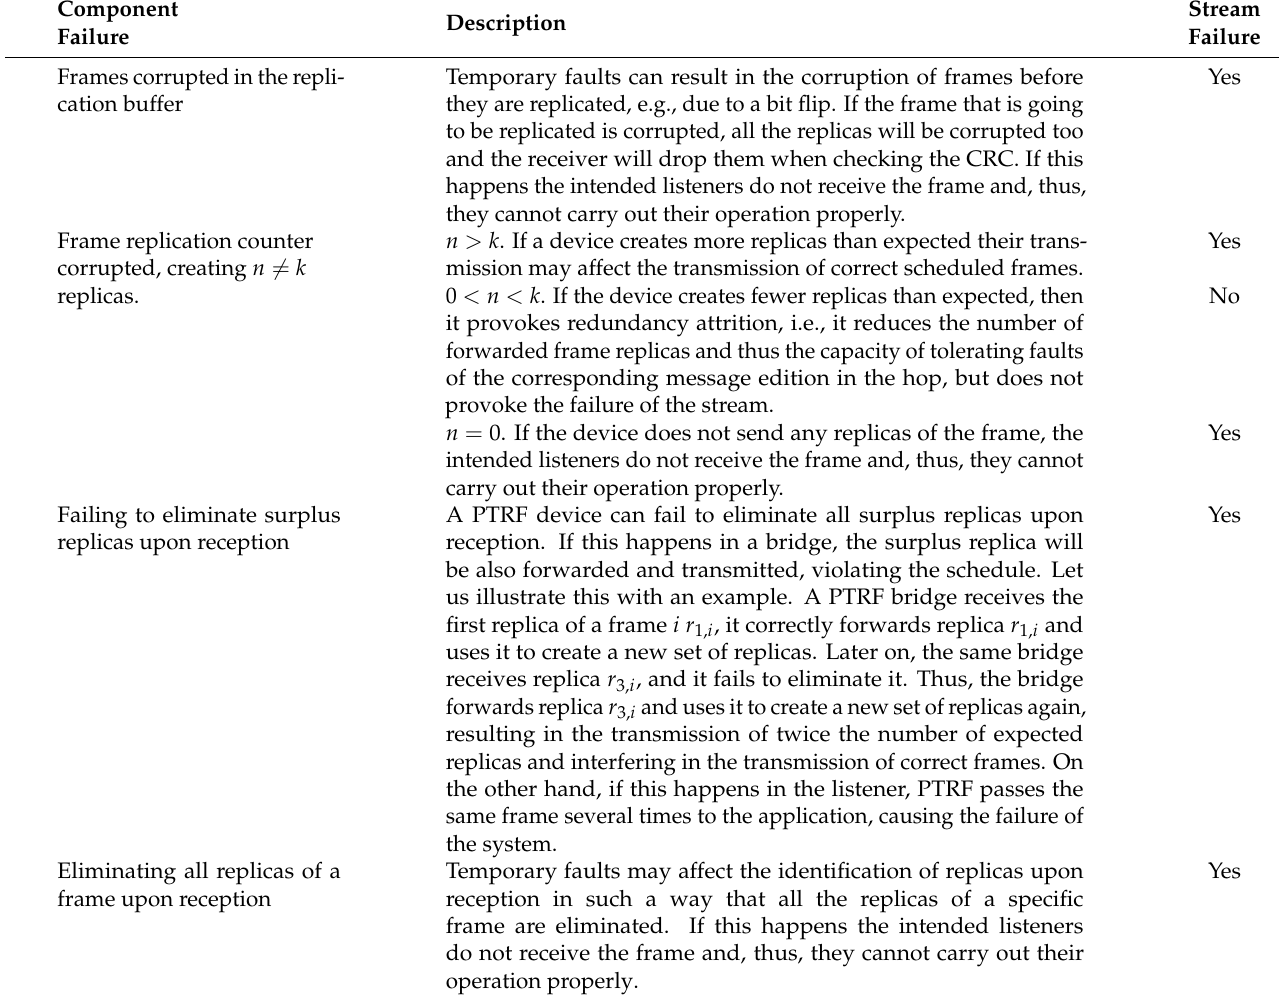
Table 2. Failure modes of PTRF-enabled devices and how they affect the overall